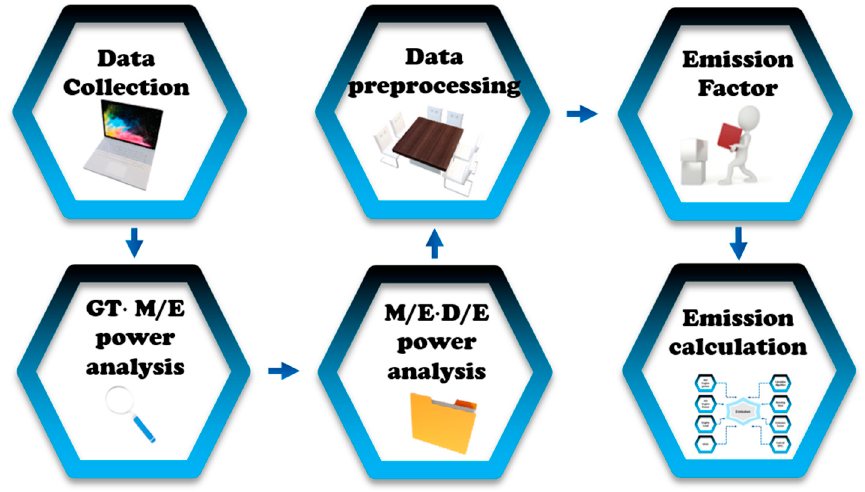
Figure 1. Process of emission